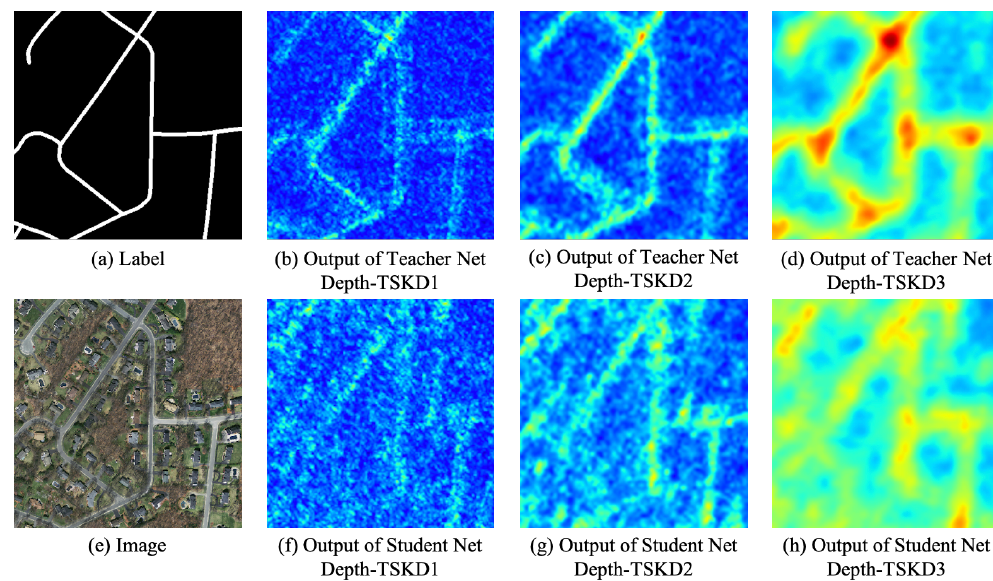
Figure 7. Visualized mid-feature layers of the topological space knowledge distillation (TSKD). The two pictures on the left are the ( a ) label and ( e ) image. The three pictures on the upper right are the outputs from the teacher net with different depth-TSKD ( b , c , d ), and the three pictures on the bottom right are the outputs from the student net with different depth-TSKD ( f , g , h